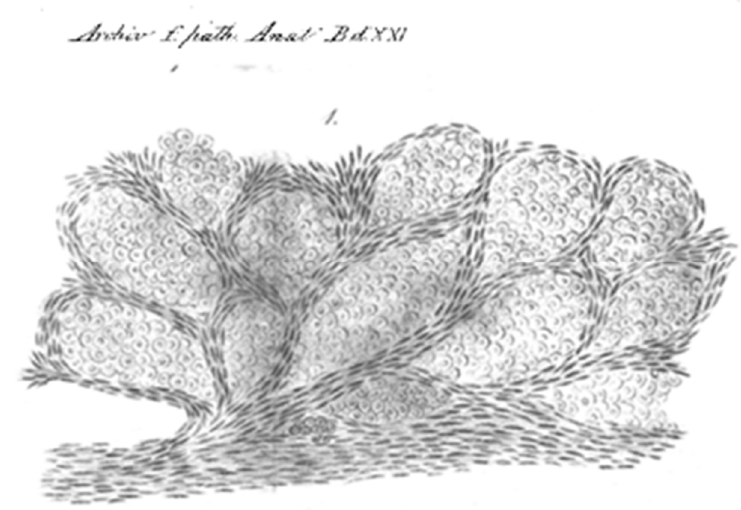
Figure 4. Camera Lucida drawing from a Johannes Erichsen paper of 1861 [58] is the oldest repro- duction, in patients with tumors in the lung, of the neoplastic cells occupying the alveolar spaces. No new vessels can be seen while the alveolar septa containing the pre-existing capillaries, produce the “chicken wire” appearance. In the word of the author: “ Cross section through a carcinoma nodule of the lungs: the alveoli are shaped by cancerous masses confined between the elastic fibers of the lung tissue ”. At the end of the 1980s in the book Tumours of the Liver and Intrahepatic Bile Ducts [59]